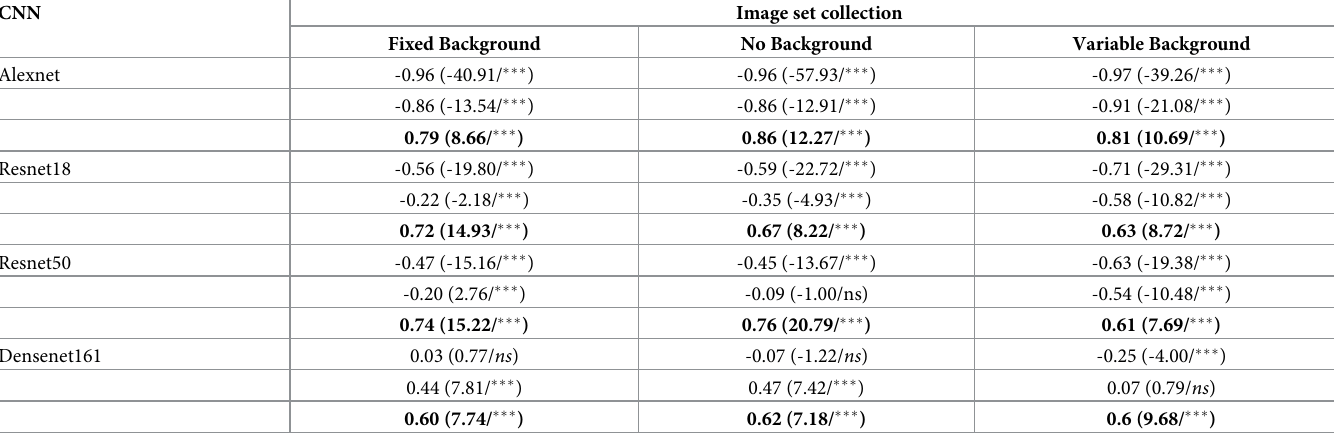
Table 3. Correlation coefficients of Euclidean distance and index measures with the rank order of the sampled CNN layers from each scene-trained CNNs for the different image collections.